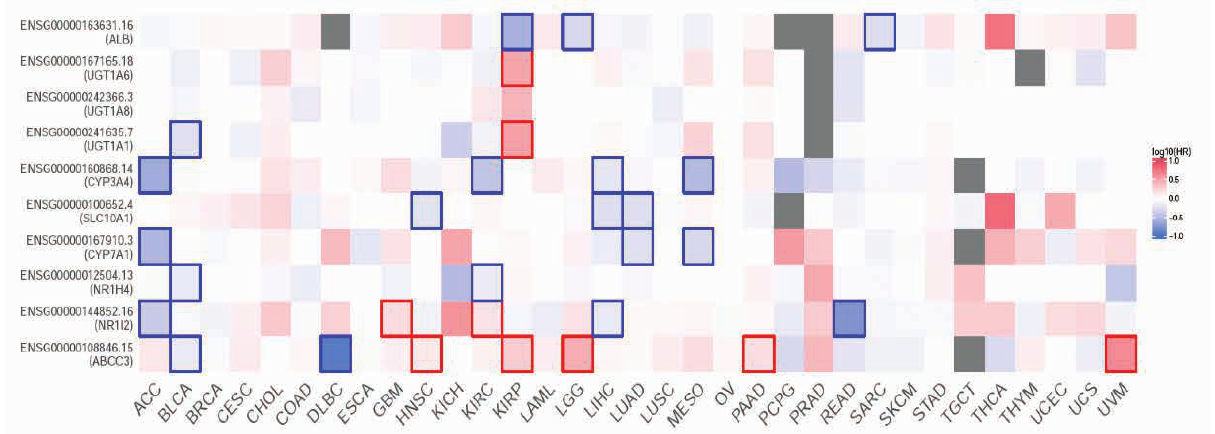
Figure 6: Survival map of hazard ratio(HR) of ABCC3 and hub genes for pan cancer